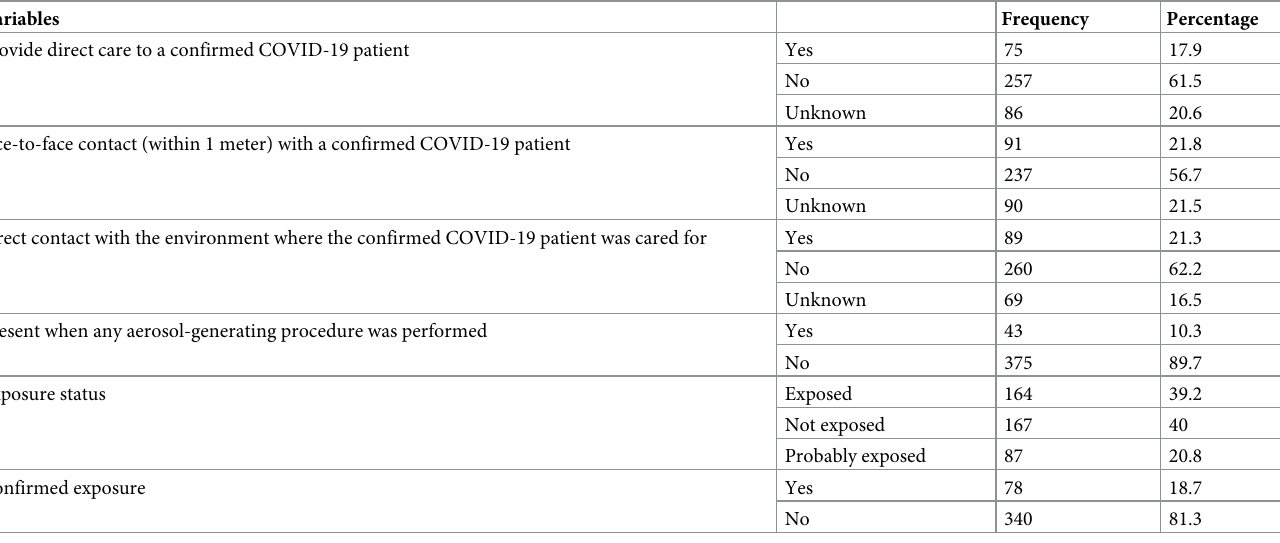
Table 2. Assessment of exposure status of health professionals for COVID 19 in Amhara region, 2020 (N = 418). Variables